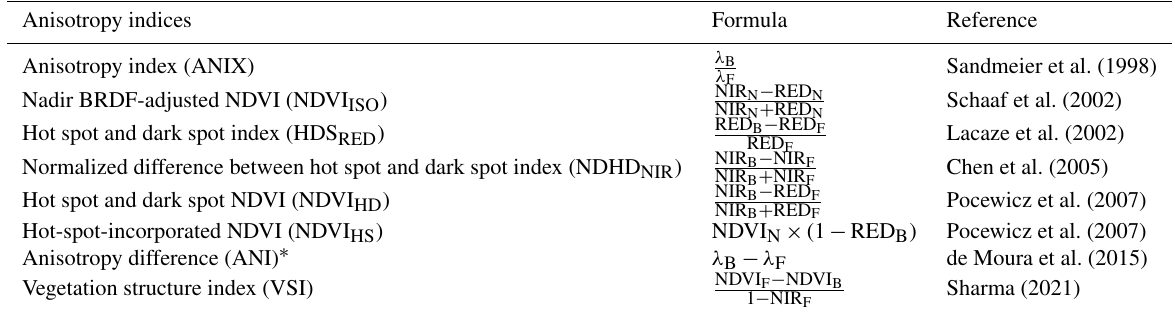
Table 3. Examples of other multi-angular anisotropy indices that can be further calculated using the layers of the AnisoVeg product. Lambda represents the selected spectral band or vegetation index. N, B, and F represent nadir view normalization, backward-scattering, and forward- scattering estimates,